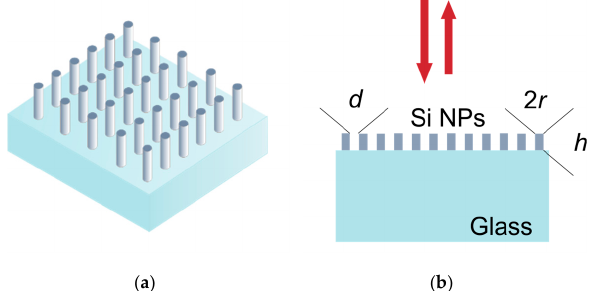
Figure 3. ( a ) Schematic of the silicon (Si) nanopillars metasurface, which consist of subwavelength Si nanopillars on a glass substrate; and ( b ) the geometry for the incident light vector and structural parameters of the metasurface.